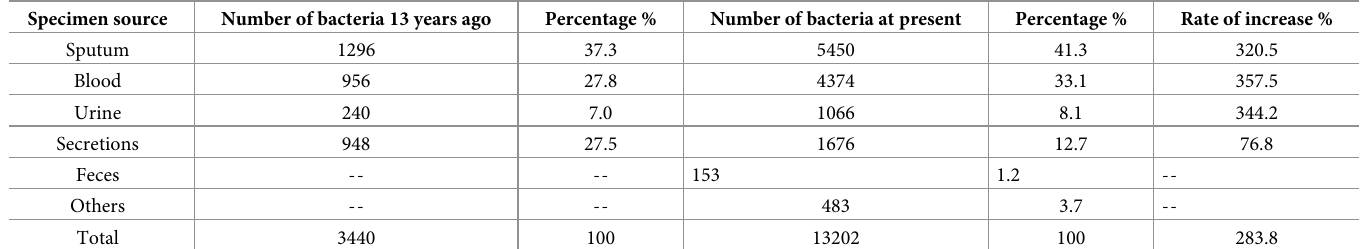
Table 1. The distribution of specimen types before and after 13 years.